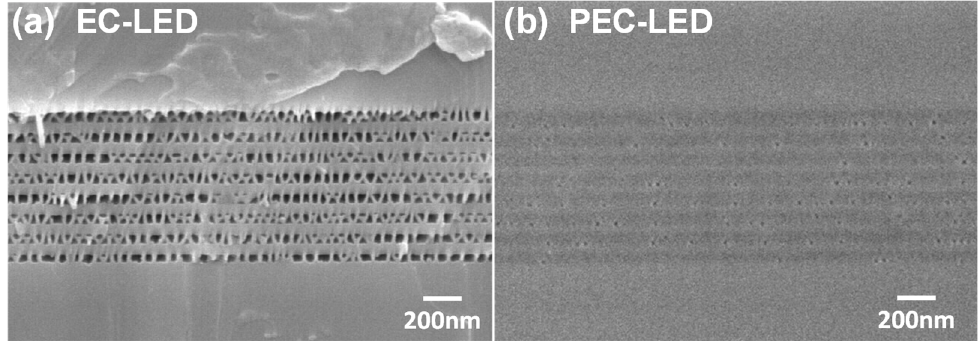
Figure 2. The SEM (scanning electron microscope) micrographs of ( a ) nanoporous GaN/GaN stack structure and ( b ) GaOx/GaN stack structure. The GaOx layer in the PEC-LED structure was prepared through the EC etching and PEC oxidized processes.